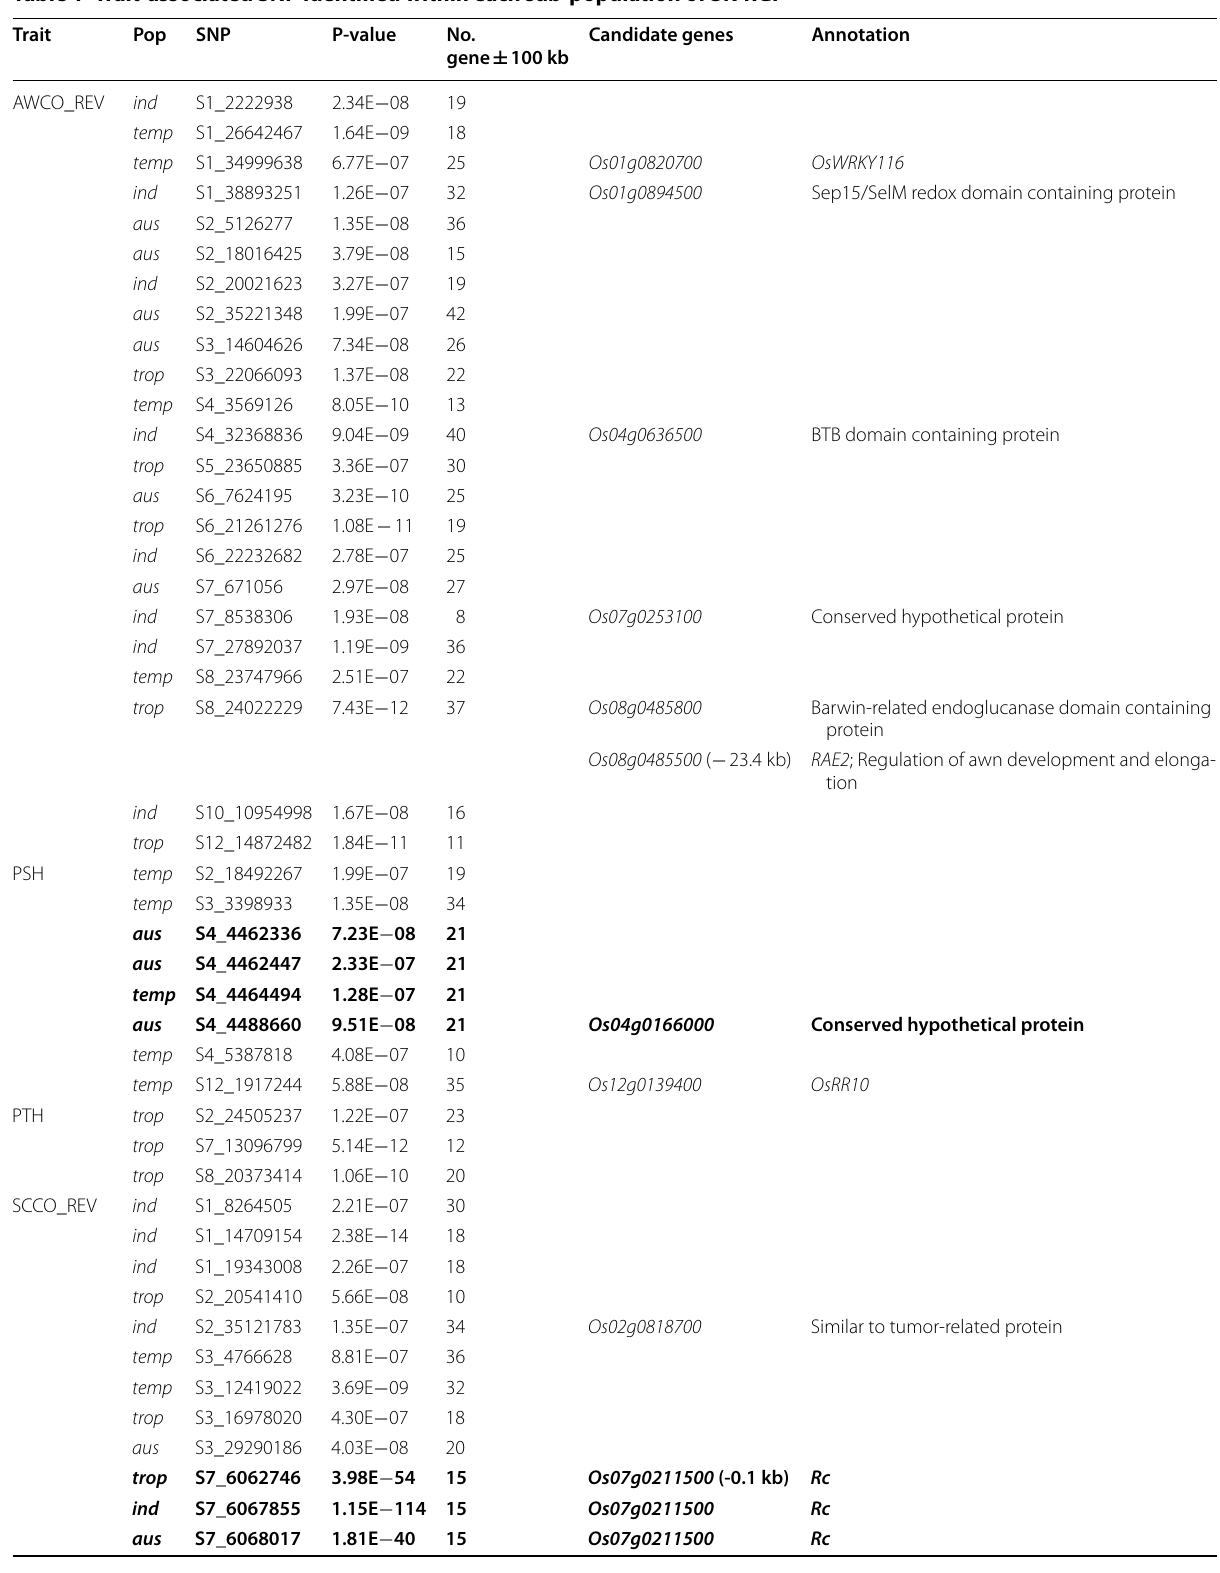
Table 1 Trait-associated SNP identified within each sub-population of 3K-RGP Trait P‑value No.